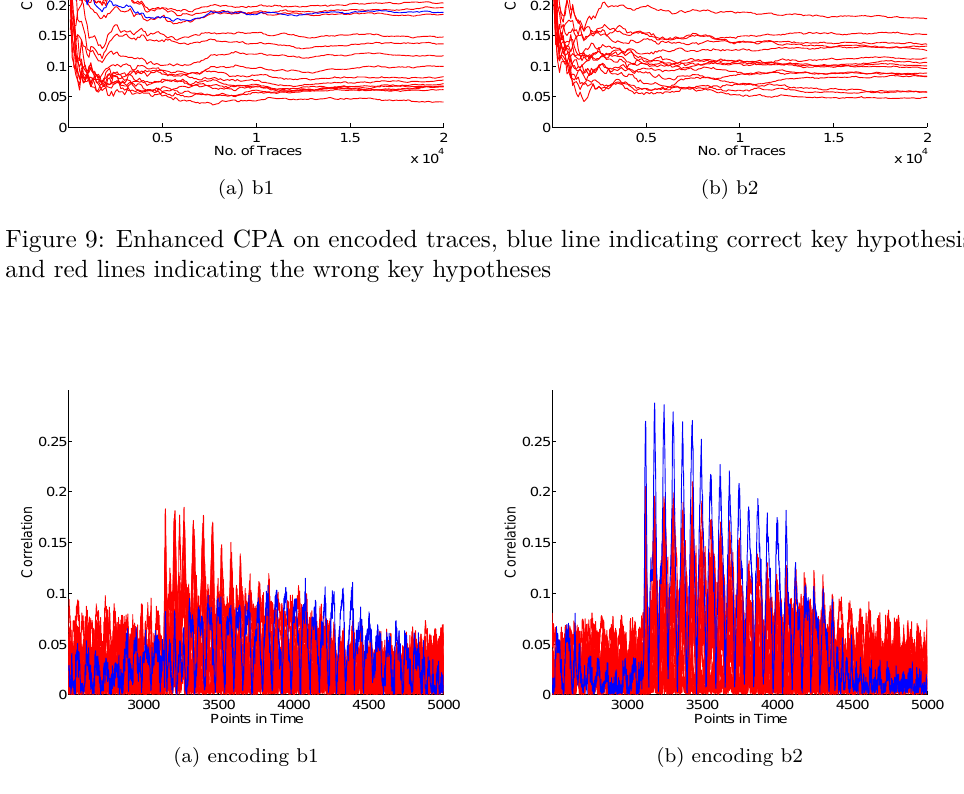
Figure 10: Enhanced CPA on encoded 100k traces, blue line indicating correct key hypothesis and red lines indicating the wrong key